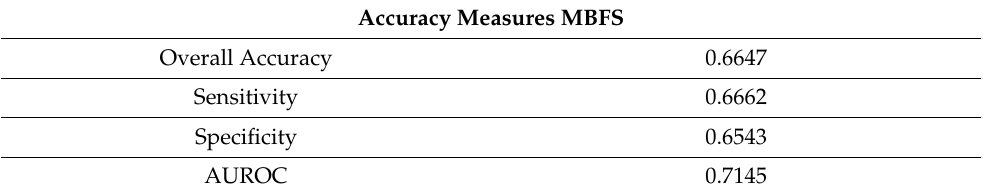
Table 2. Accuracy measures for the MBFS model over the test dataset ( n = 5210). The values of overall accuracy, sensitivity, specificity, and area under the receiver operation characteristics (AUROC) curve are displayed (the selected threshold for the predicted probabilities was set to 0.5).